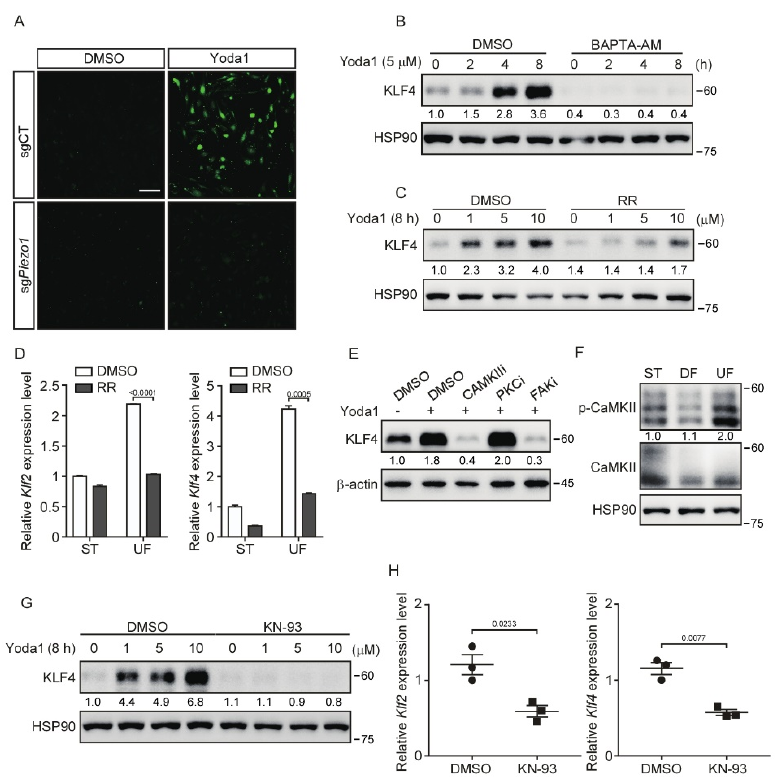
Figure 4. Inhibition of CaMKII suppresses PIEZO1/MEKK3-mediated KLF2/4 expression. ( A ) Con- trol and Piezo1 -dificient MBMECs were pretreated with Fluo-4 AM (2 µ M) for 1 h and then treated with Yoda1 (5 µ M) for 10 min. Calcium imaging was analyzed under a fluorescence microscope. Scale bars, 50 µ m. ( B ) MBMECs were pretreated with calcium chelator (BAPTA-AM, 10 µ M) for 2 h and then treated with Yoda1 (5 µ M) for the indicated time. KLF4 proteins were monitored by western blotting. ( C ) MBMECs were pretreated with L-type calcium current blocker, Ruthenium Red (RR, 10 µ M), for 2 h and then treated with Yoda1 with the indicated concentration for 8 h. KLF4 proteins were monitored by western blotting. ( D ) MBMECs were treated with RR (10 µ M) in presence of shear stress exposure for 5 days, and mRNA levels of Klf2 and Klf4 were measured by quantitative RT-PCR. ( E ) MBMECs were pretreated with CaMKII inhibitor (KN-93, 10 µ M), PKC inhibitor (Bisindolylmaleimide I, 10 µ M) and FAK inhibitor (TAE226, 10 µ M) for 2 h and then treated with Yoda1 (5 µ M) for 8 h. KLF4 proteins were monitored by western blotting. ( F ) MBMECs were exposed to differential shear stress for 5 days, and cell lysates were probed with indicated antibodies. ( G ) MBMECs were pretreated with KN-93 (10 µ M) for 2 h and then treated with Yoda1 (5 µ M) for 8 h. KLF4 proteins were monitored by western blotting. ( H ) Wild-type male ICR mice were injected with KN-93 (2 mg/kg) via tail vein every 12 h for 4 times, and thoracic aortas were collected for quantitative RT-PCR of Klf2 and Klf4 mRNA expression. n = 3 mice/group. Data are representative of three independent experiments and are presented as mean ± SEM of three technical replicates by an unpaired Student’s t -test ( D ). The immunoblot was measured using ImageJ to determine the relative intensities of the indicated bands, which were normalized using the internal loading control